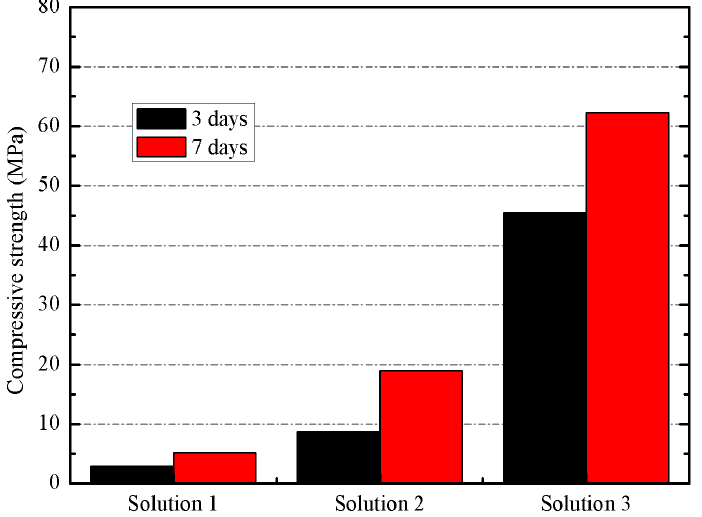
Figure 5. Compressive strength of mortars activated with different activating